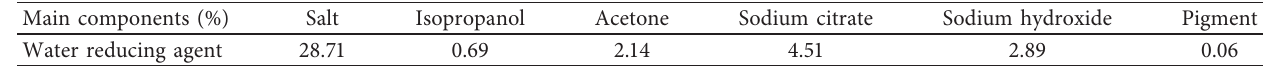
Table 2: The main chemical properties of water reducing agent.